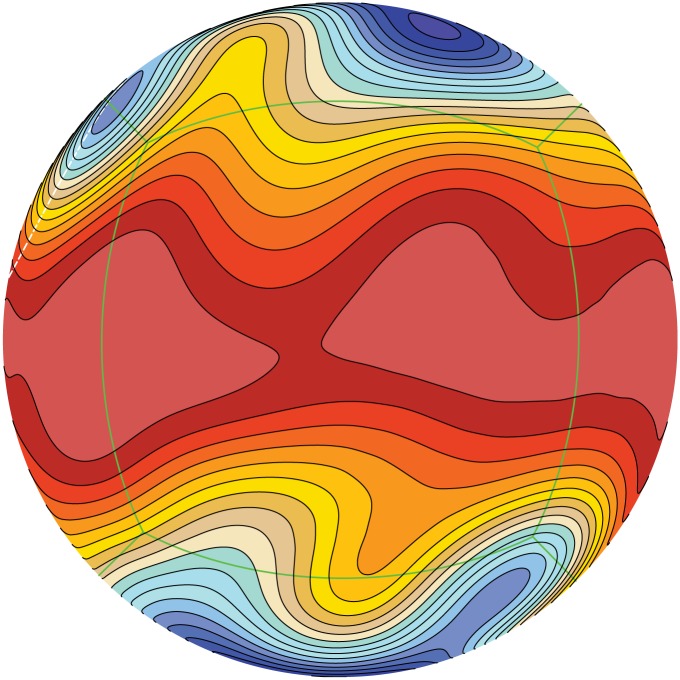
Surface level distribution of the atmosphere at day 15 on Tianhe-2 based on the model test [34].